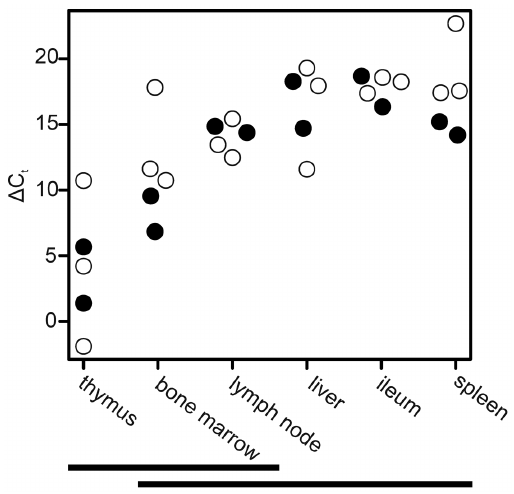
Figure 4. TdT mRNA expression level in adults and fetuses. The expression level was measured with RT-qPCR. Material consisted of 3 fetuses and 2 adults. Thymus, bone marrow and lymph node had elevated expression levels compared to liver, ileum and spleen. Fetuses did not differ from adults. 18S normalized cycle threshold values ( D C t ) are shown. Tissues not differing statistically ( a =0.05) from each other are indicated by a horizontal bar. White points indicate fetuses and black points indicate